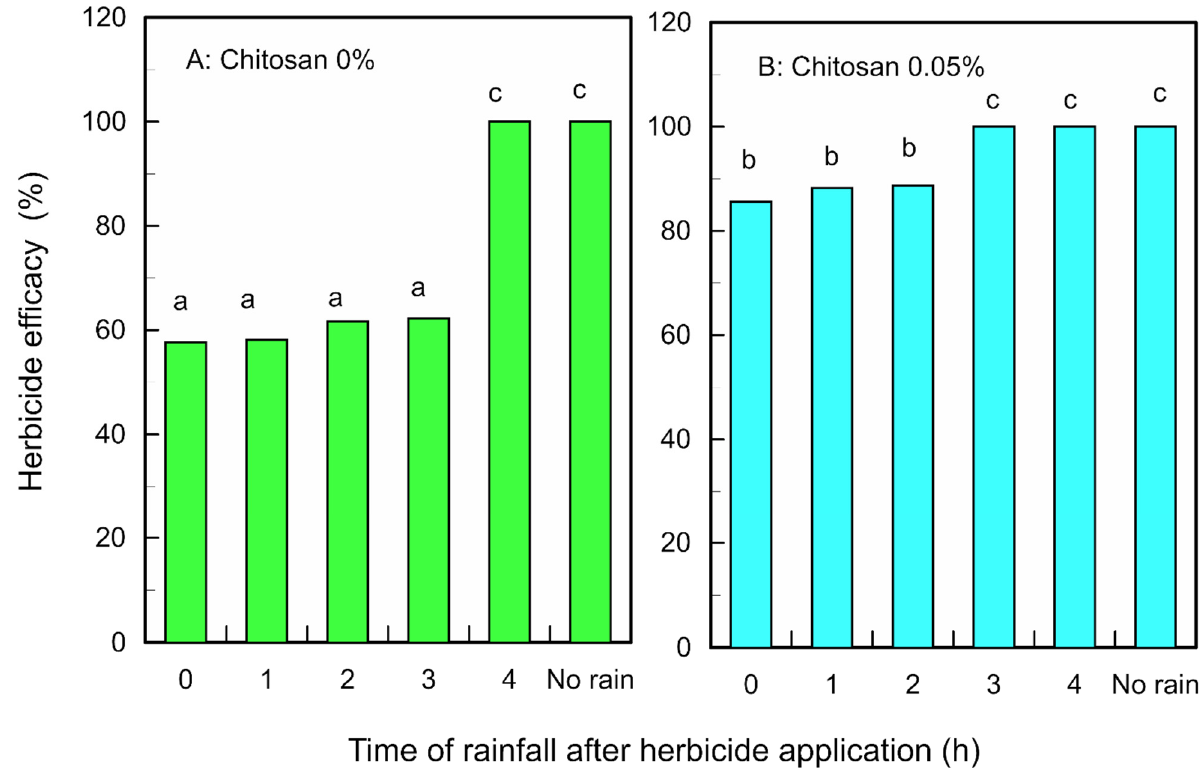
Figure 2. Effect of simulated rainfall at different time intervals after paraquat application on Ageratum conyzoides. ( A ): Chitosan 0%, ( B ): Chitosan 0.05%, Different letters show significant differences at the level of 5% according to Duncan’s test. Table 1. Effect of simulated rainfall on herbicidal efficacy of a mixture of paraquat and chitosan against Ageratum conyzoides at different time intervals after mixture application.